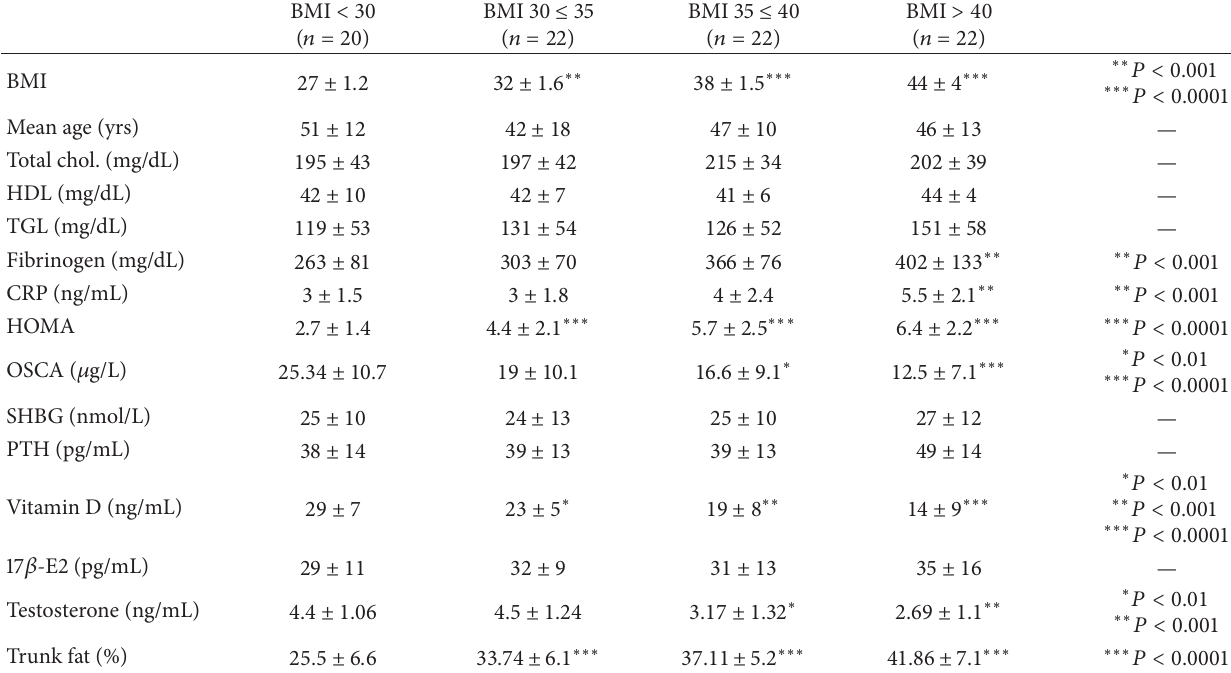
Table 1: Biochemical and hormonal characteristics of the patients according to different BMI. Values are expressed as means ± SD.